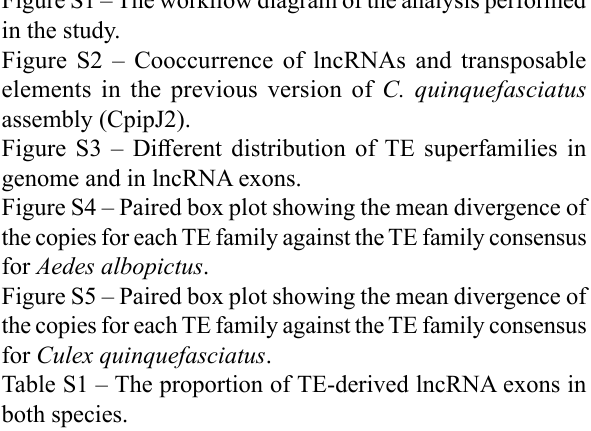
Figure S3 – Different distribution of TE superfamilies in genome and in lncRNA exons. Figure S4 – Paired box plot showing the mean divergence of the copies for each TE family against the TE family consensus for Aedes albopictus . Figure S5 – Paired box plot showing the mean divergence of the copies for each TE family against the TE family consensus for Culex quinquefasciatus . Table S1 – The proportion of TE-derived lncRNA exons in both